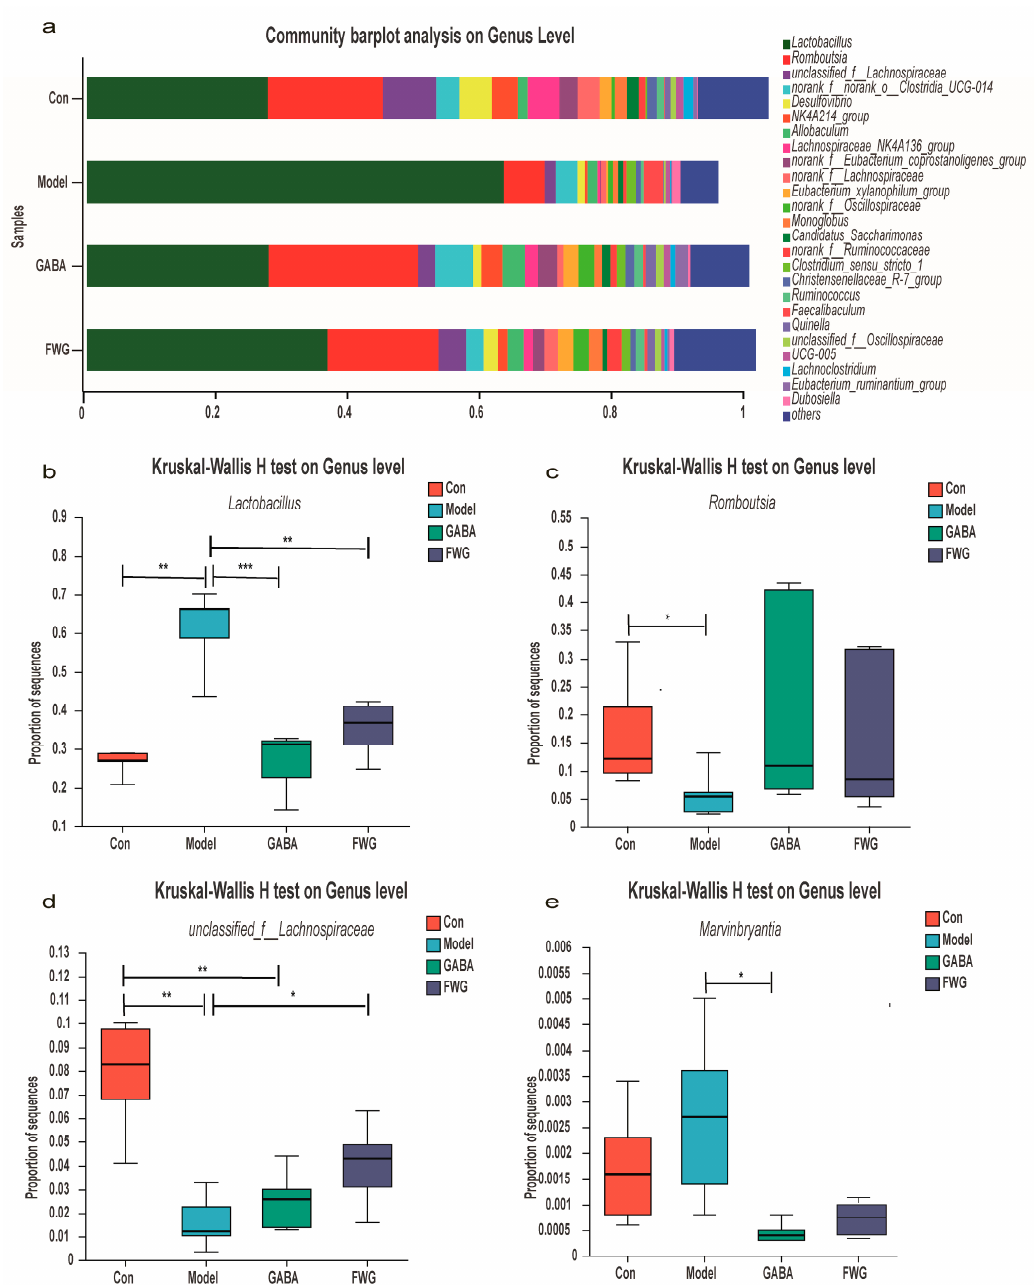
Figure 6. FWG regulated the composition of the gut microbiota at the genus level. ( a ) Community bar-pot analysis at the genus level. ( b ) Kruskal–Wallis H test box line graph for Lactobacillus. ( c ) Kruskal–Wallis H test box line graph for Romboutsia . ( d ) Kruskal–Wallis H test box line graph for unclassified_f__Lachnospiraceae . ( e ) Kruskal–Wallis H test box line graph for Marvinbryantia . (* p < 0.05, ** p < 0.01, *** p < 0.001 indicates a statistically significant difference.)